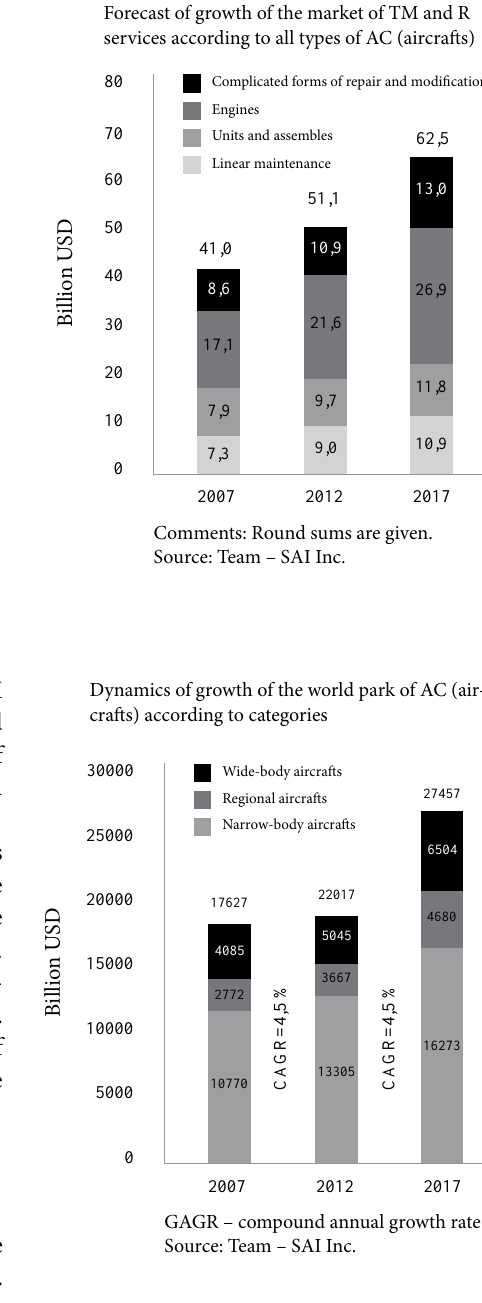
Fig. 1. Forecast of the market of TM and RS